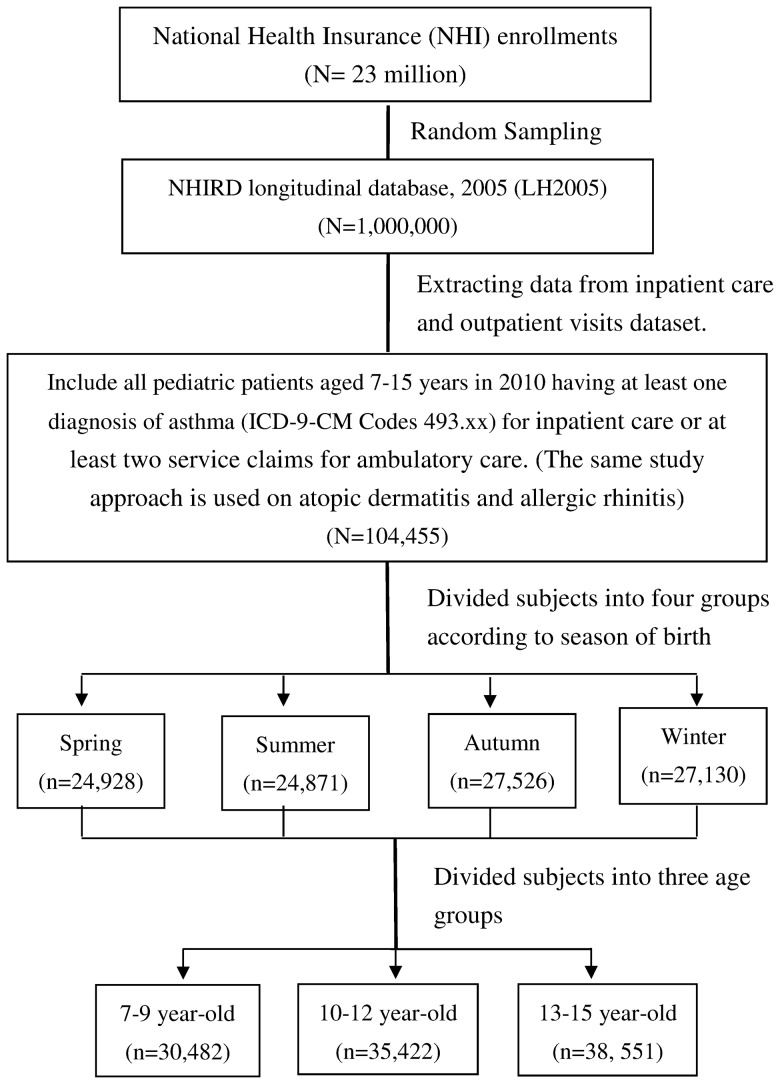
Flow Chart of the Selection of Study Subjects from the National Health Insurance Research Database in Taiwan.